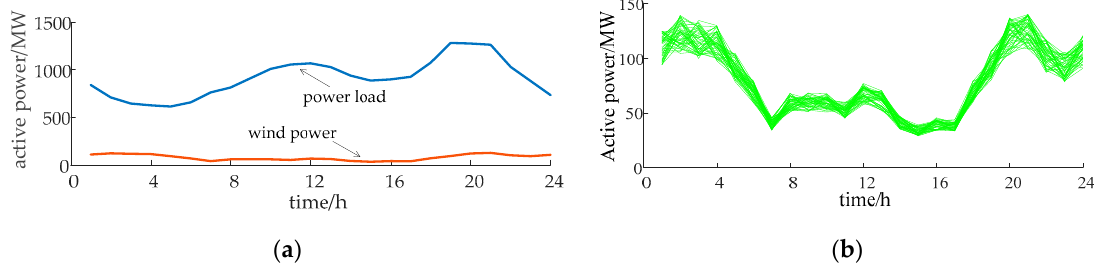
Figure 4. Power load and wind power. ( a ): power load and wind power, ( b ): wind power output scenarios.